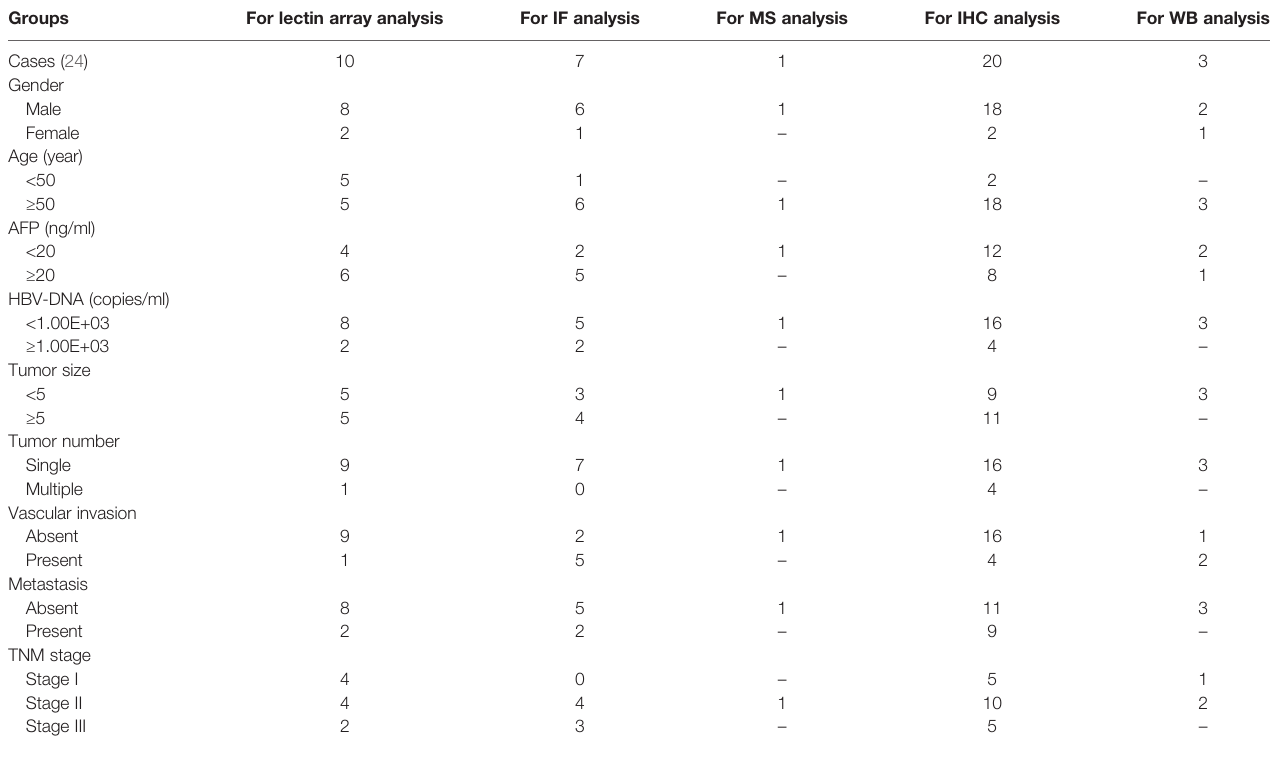
TABLE 1 | Summary of clinical characteristics of human HCC